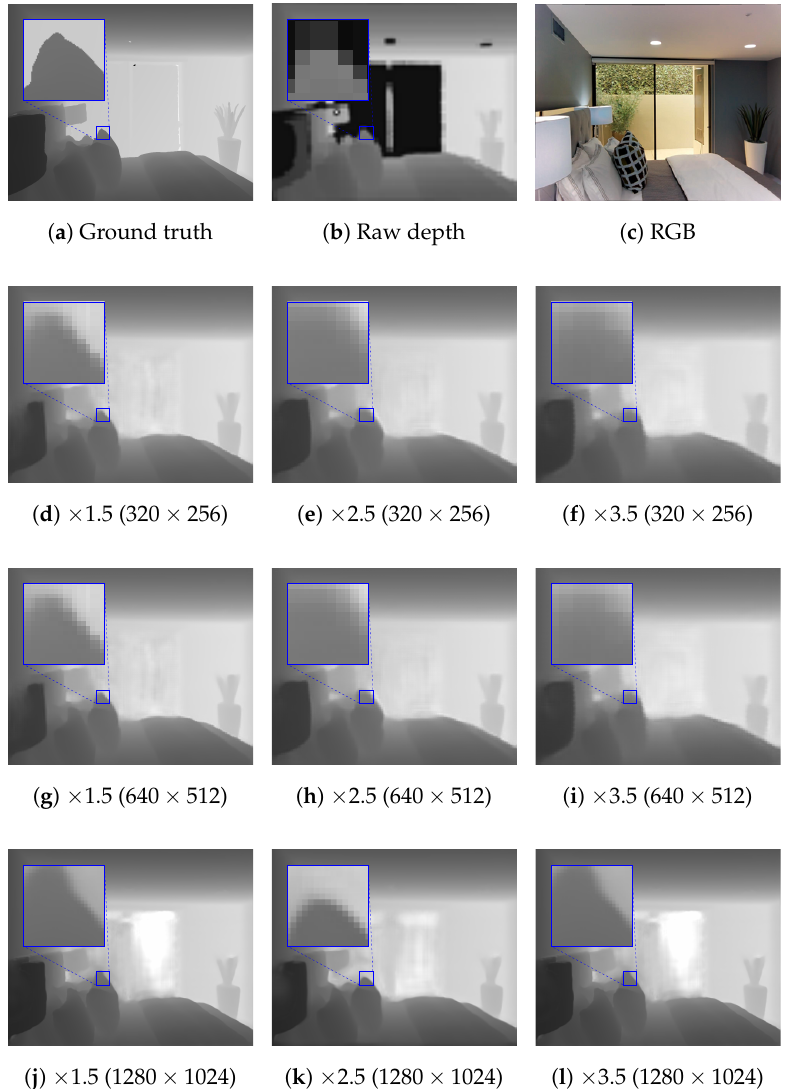
Figure 16. Visual comparison of DSR and depth completion on the Matterport3D dataset [43] using the resolutions of 320 256, 640 512, and 1280 × × ×